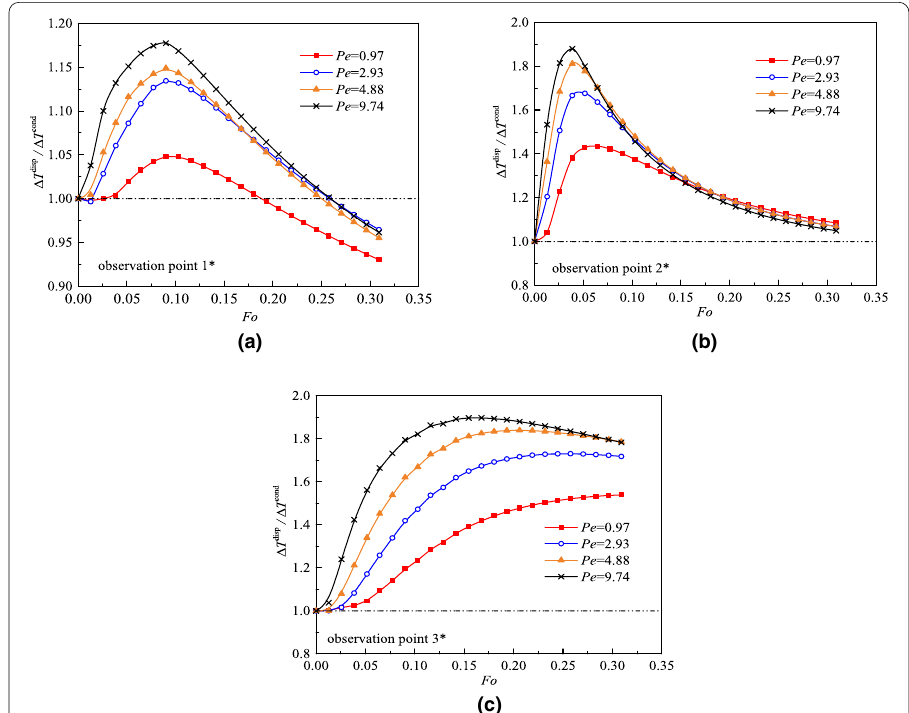
Fig. 11 Temperature response dynamic curve in the fine sand aquifer at the first cooling stage: a the upstream area of the BHEs (the observation point 1*); b the inside area of the BHEs (the observation point 2*); c the downstream area of the BHEs (the observation point 3*)